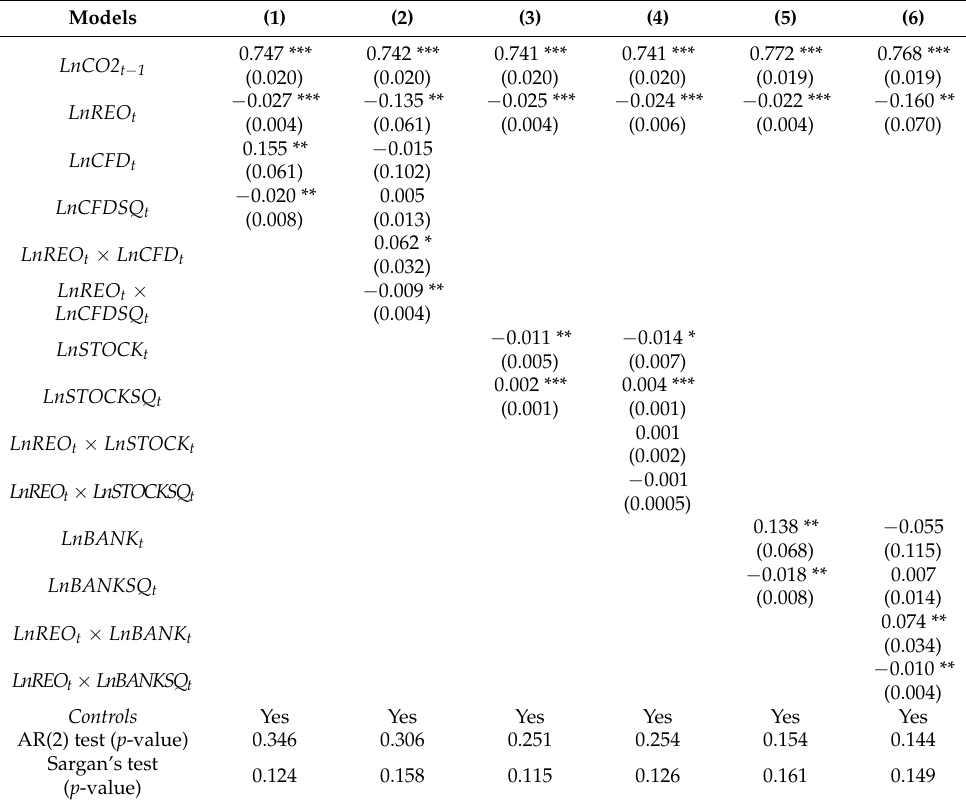
Table 4. Results of GMM model with LnREO and with the squared term of financial development.